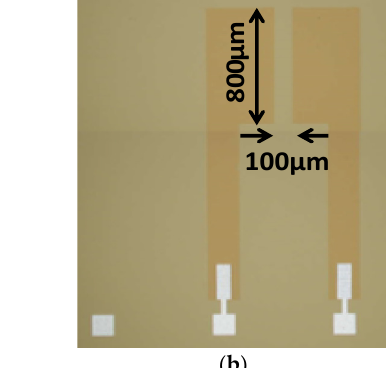
2 -gate FET; ( b ) Si 3 N 4 -gate FET.